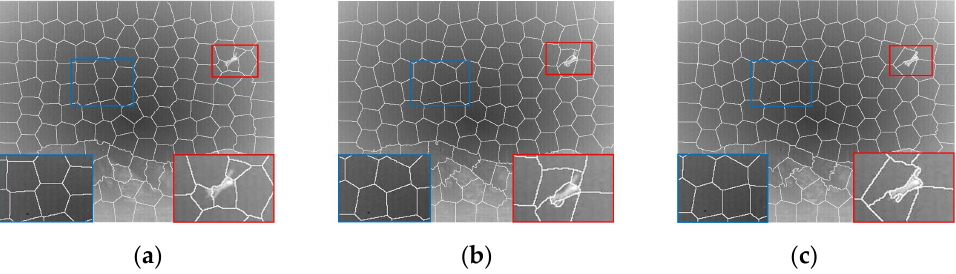
Figure 15. Ablation study on the impact of the spatial proximity weight and edge penalty term. ( a ) Result without any constraints; ( b ) result only with the spatial proximity weight; ( c ) result of